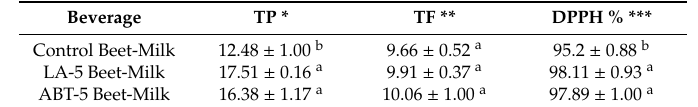
Table 5. Total phenolics, total flavonoids, and DPPH% free radicals scavenging activity of control and fermented beet-milk.